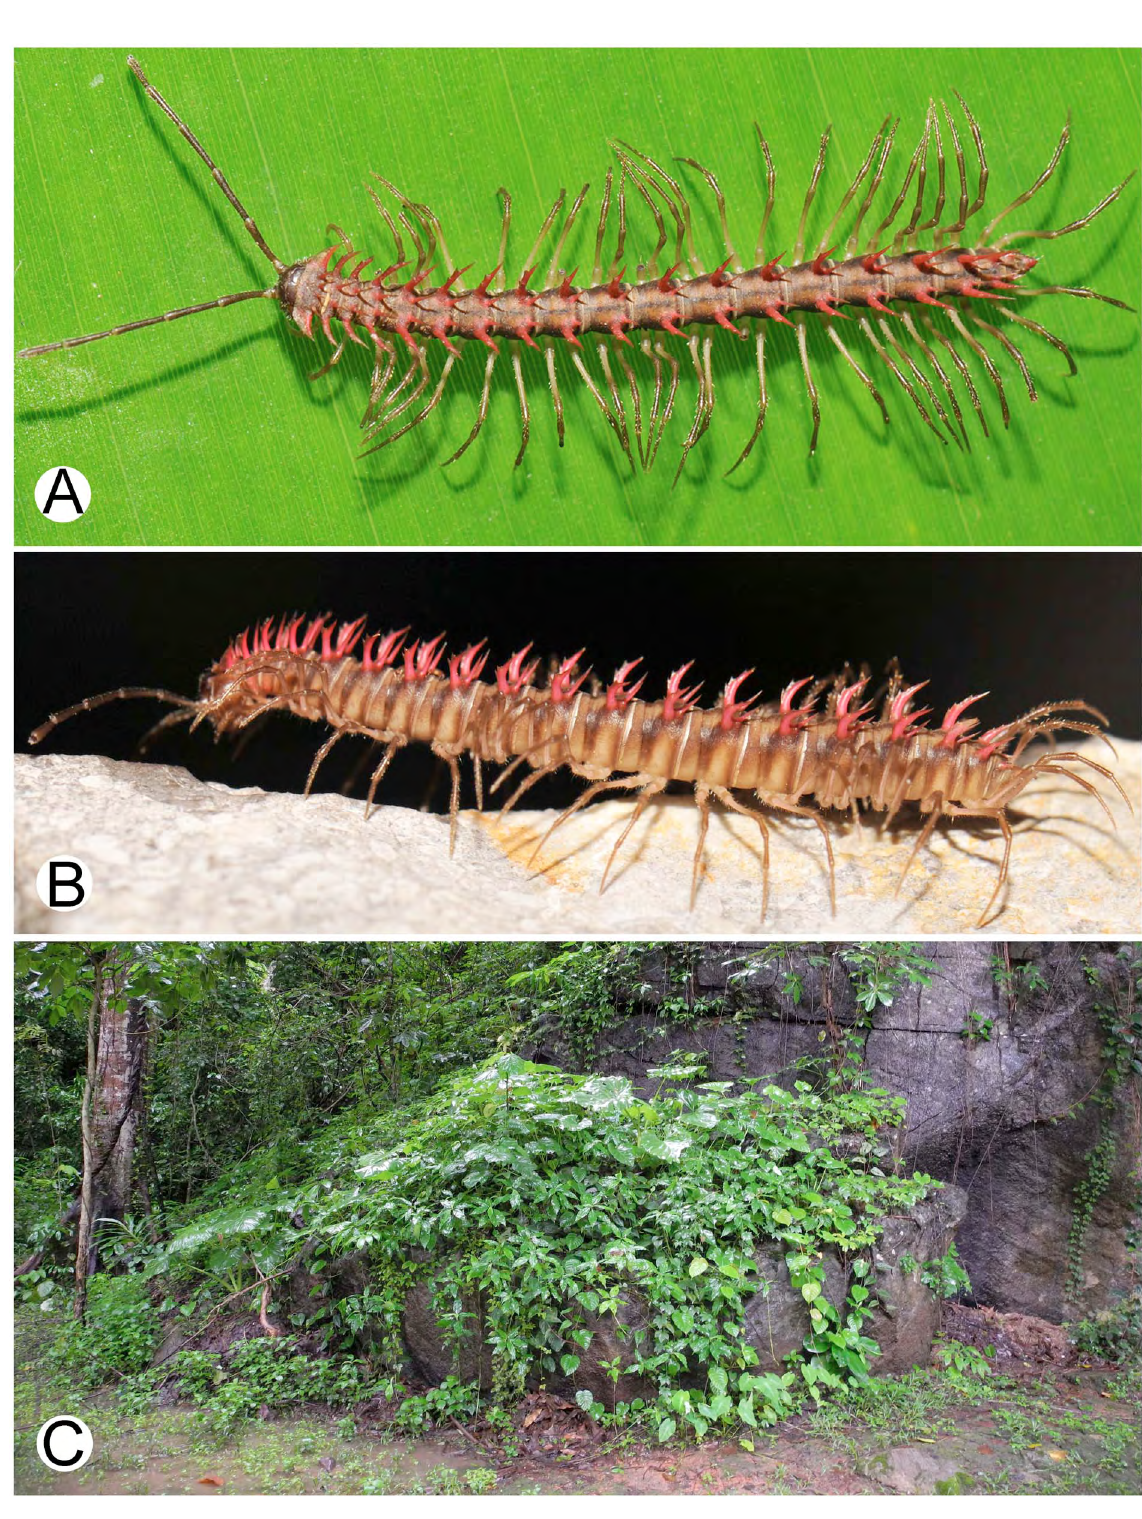
Fig. 17. Live photographs and habitat of Nagaxytes gracilis Srisonchai, Enghoff & Panha gen. et sp. nov. (specimens from Daowadueng Cave, Thailand). A . ♂, paratype (CUMZ-pxDGT00091). B . ♀, paratype (CUMZ-pxDGT00098). C .